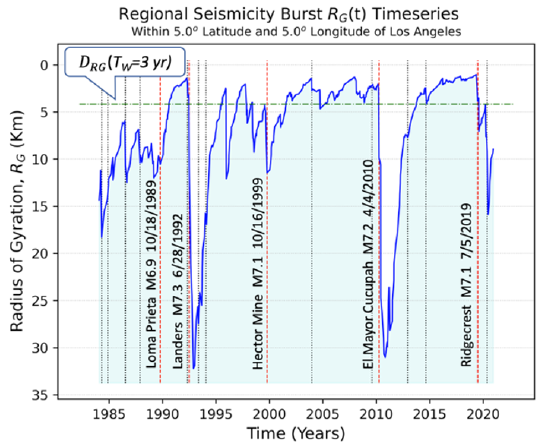
Figure 3. Earthquake burst